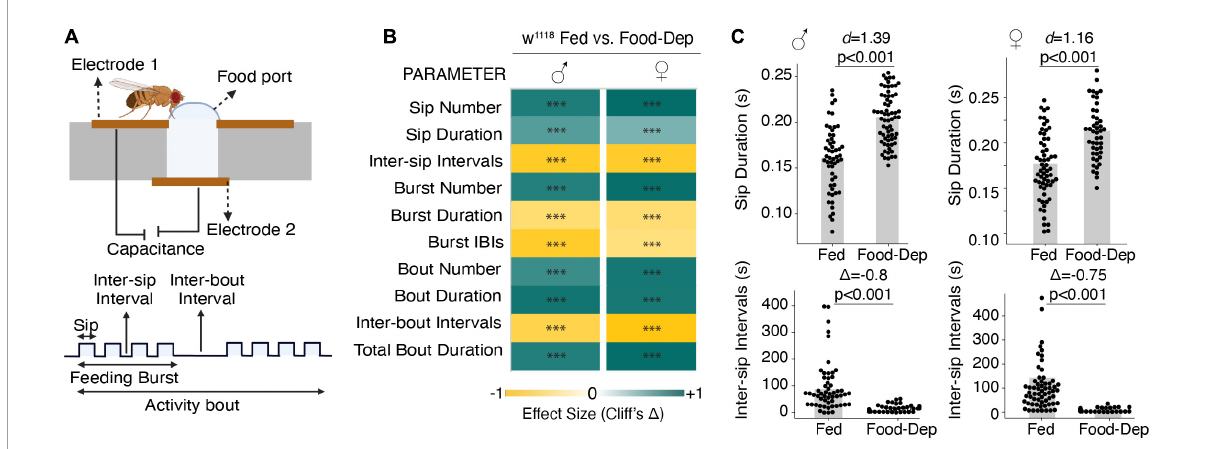
FIGURE1 Prolonged food deprivation induces feeding by modulating feeding microstructure. (A) Schematic depicting the FlyPAD setup and the feeding microstructure parameters measured in fed and 24-h food-deprived flies. (B) Heat maps showing the effect sizes (Cliff’s (cid:49) ) between fed and food-deprived male and female flies for the ten feeding parameters measured using FlyPAD. (C) Cumming estimation plots of the sip duration and inter-sip intervals. Food-deprived flies show an increase in sip duration compared with fed flies during the assay (3,600 s) in both males [ n = 54–67, d = 1.39 (95 CI 0.97, 1.8), p < 0.001] and females [ n = 52–61, d = 1.16 (95 CI 0.759, 1.54), p < 0.001]. Food-deprived flies show a decrease in inter-sip intervals compared with fed flies during the assay (3,600 s) in both males [ n = 55–65, (cid:49) = –0.822 (95 CI –0.92, –0.65), p < 0.001] and females [ n = 52–61, (cid:49) = –0.75 (95 CI –0.89, –0.56), p < 0.001] In the heatmap, green indicates an increase in effect size, and yellow indicates a decrease in effect size in food-deprived compared to freely feeding flies. p -values for the effect size measure are indicated with an asterisk ∗ p < 0.05, ∗∗ p < 0.01, and ∗∗∗ p <